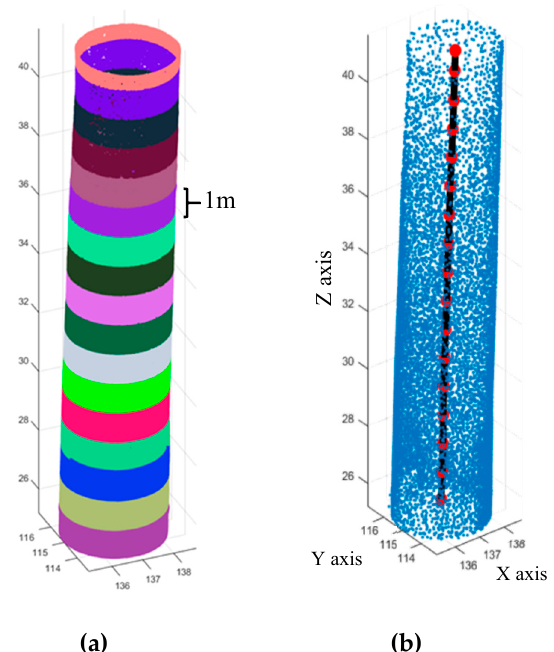
Figure 12. Multi cylinder primitive fitting results of the shrine minaret. ( a ) The cylindrical minaret body is divided into multiple 1 m sections. ( b ) The barycentric coordinates at each height level is computed through a cylinder fitting. Table 3. The best fitting cylinder parameters of the multi sections along the minaret structure.